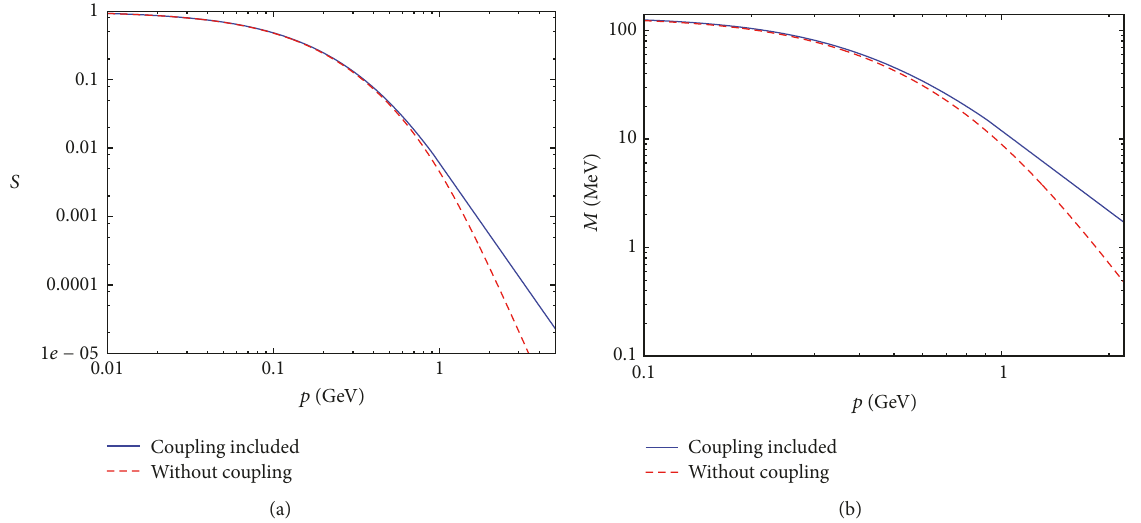
Figure13:(a)Scalarformfactorand(b)massfunctionobtainedfromthe(quenched)solutionofthequarkgapequation.Resultsarepresented for 𝑔 ≃ 2.1 (full curve) and 𝑔 = 0 (dashed